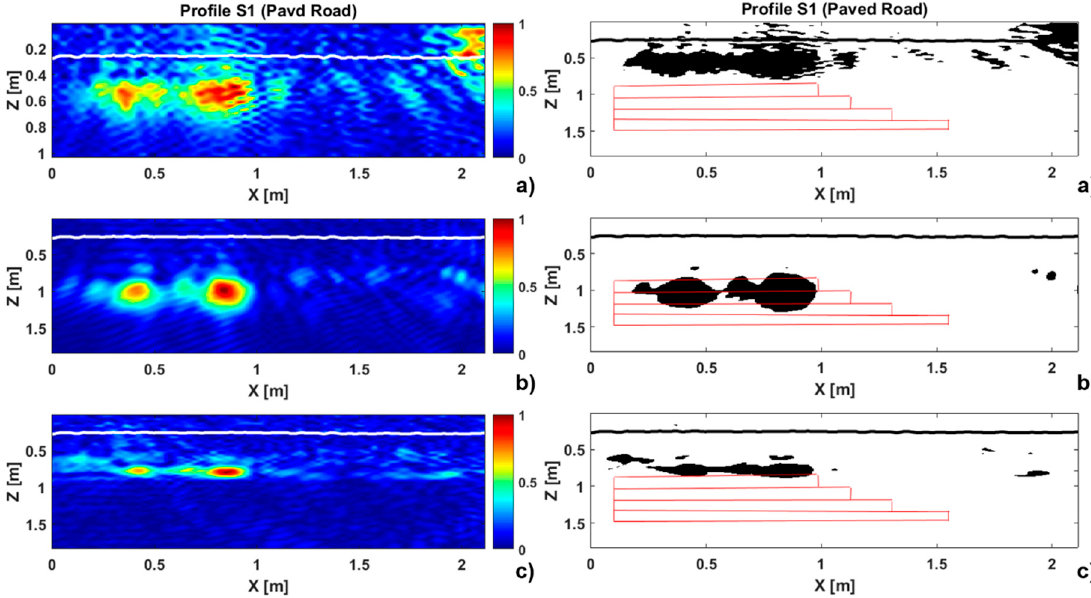
Figure 14. Portion of the tomographic ( left panels ) and binary ( right panels ) images related to the buried paved road in the profile S1; panels ( a – c ) shown the tomographic reconstruction obtained with relative permittivity of the freshwater ( ε w ) , the wet sand ( ε ws ) , and that equivalent respectively. The white lines represent the bathymetry profiles. The tomographic images show the normalized intensity of the retrieved contrast. The boundaries of the true paved road are superimposed in red on the binary images. Table 2. Values of the all buried objects for both considered profiles in terms of upper side location